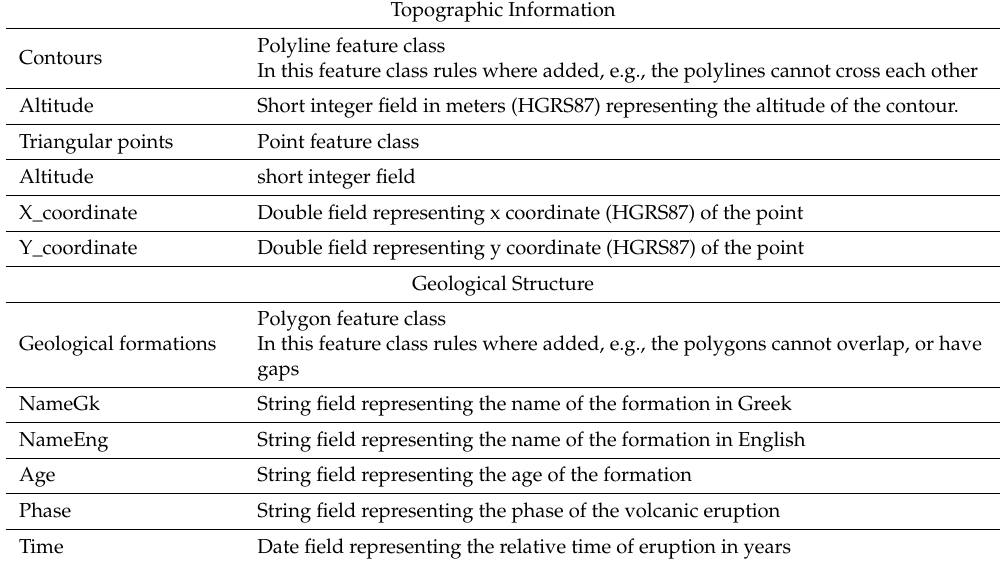
Table 1. File Geodatabase schema for the available bibliographic data.